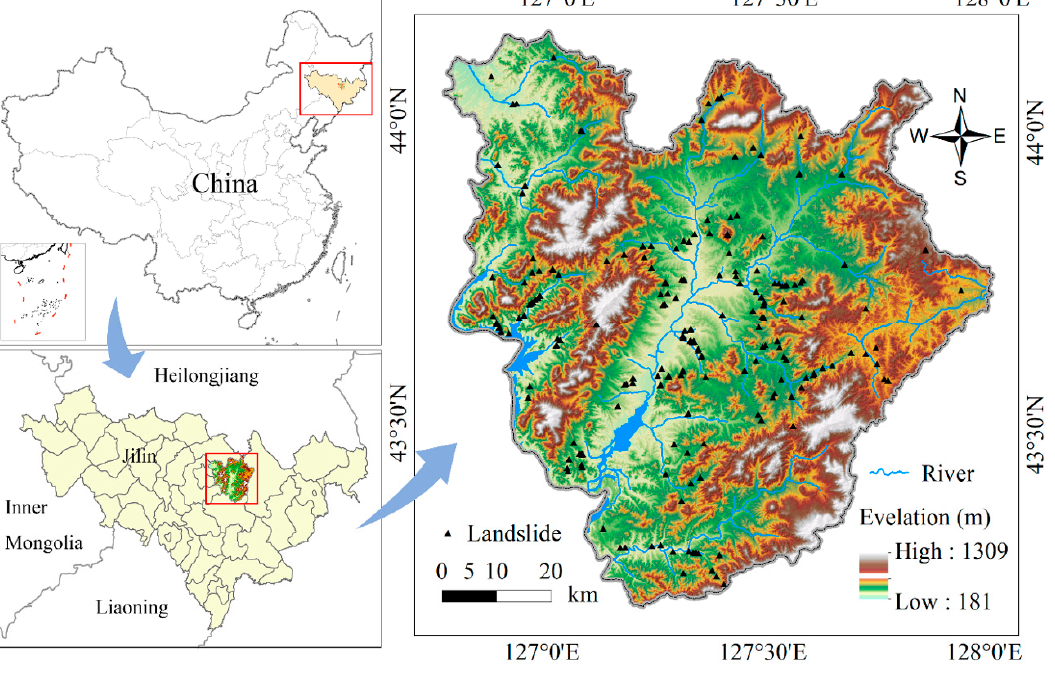
Figure 1. Location of the study area.